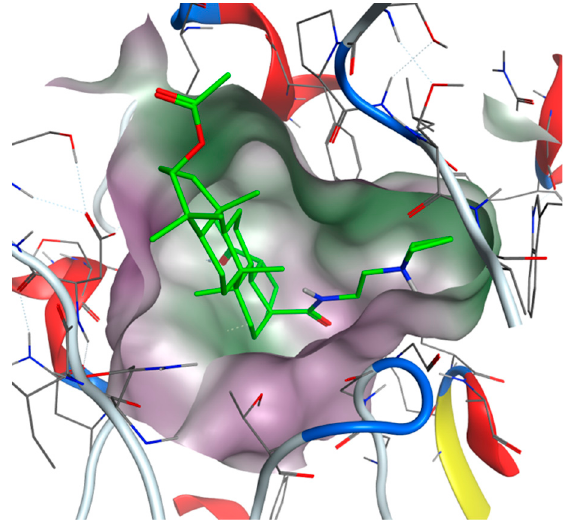
Figure 5. View from the top to the binding site of BChE with bound compound 35 (green colored: carbon atoms) with displayed lipophilic potential (green surface). The more hydrophilic site is colored magenta.